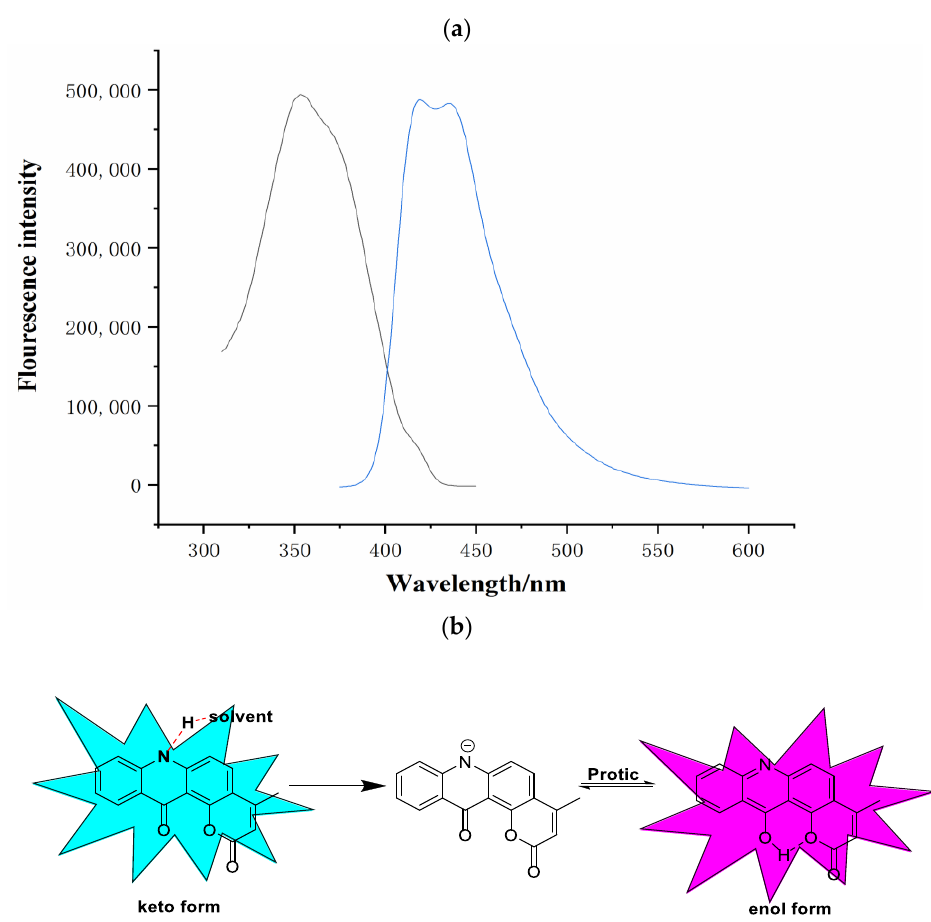
Figure 4. ( a ) Excitation spectra (black line, λ em : 420 nm) and emission spectra (blue line, λ ex = 355 nm) of probe S (real values in fluorescence intensity). ( b ) Two proton transfer tautomers of probe S.